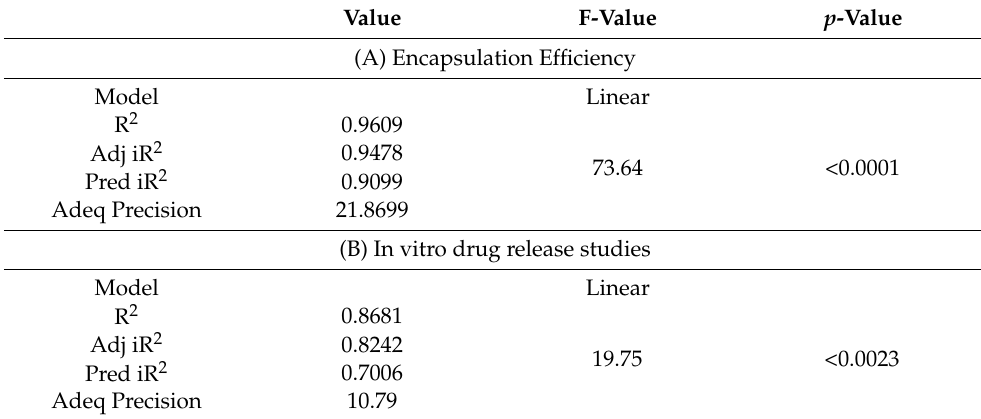
Table 4. ANOVA data for all